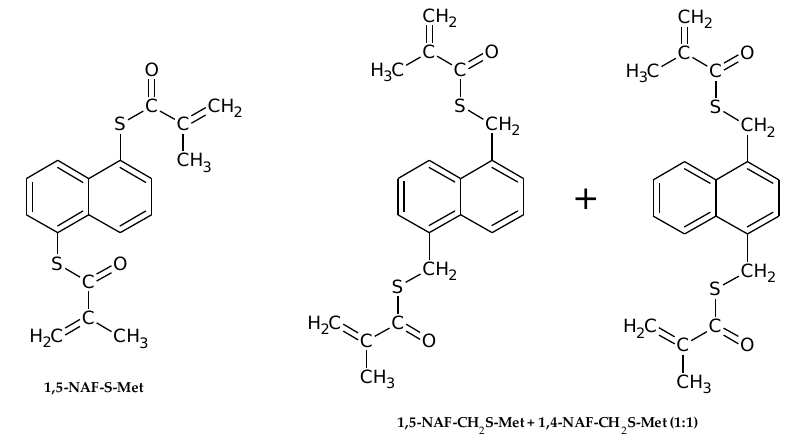
Figure 1. The structures of synthesized thioesters.